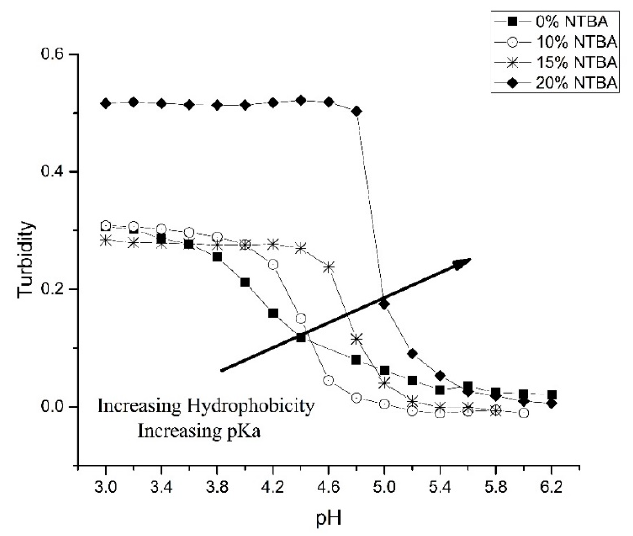
Figure 5. The effect of NTBA on the pH response profiles of several crosslinked copolymers of NIPA and MAA (NK 1-72, NK 1-77, NK 1-56, and NK